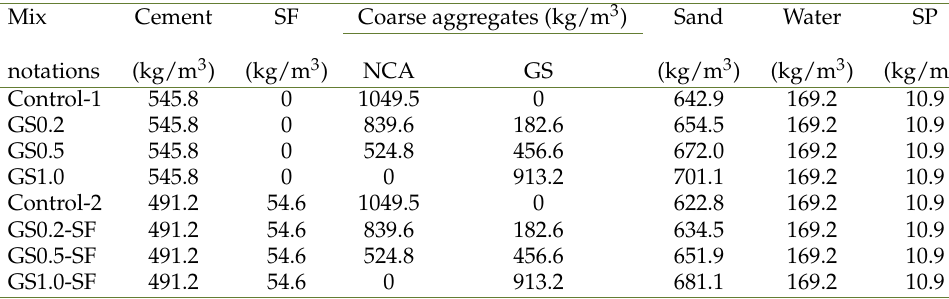
Table 1. Material proportions of concrete specimens